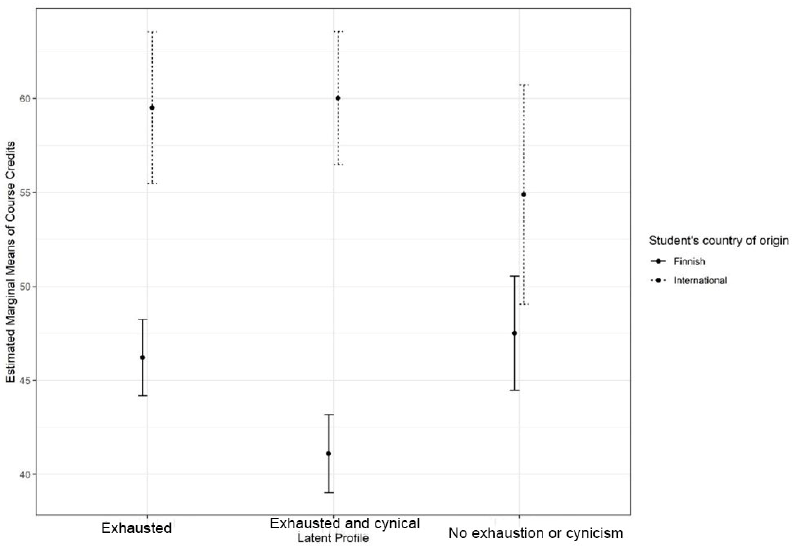
Figure 2. Credits. Means of course credits across the latent profiles for domestic and international students with 95% confidence intervals.